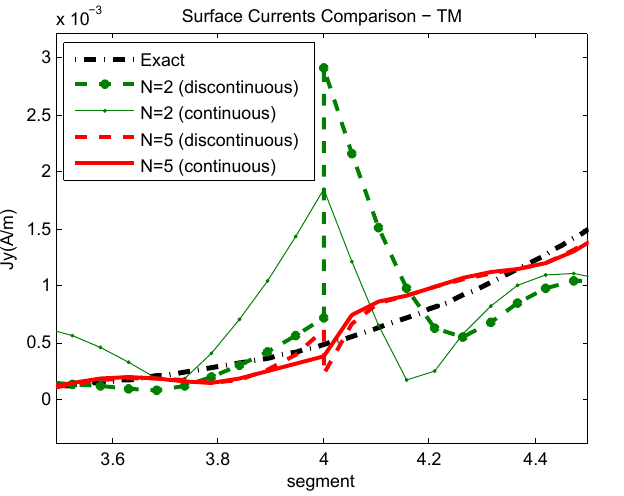
Figure 9: (TM polarization) Surface currents ( N = 2) in the extremity zone